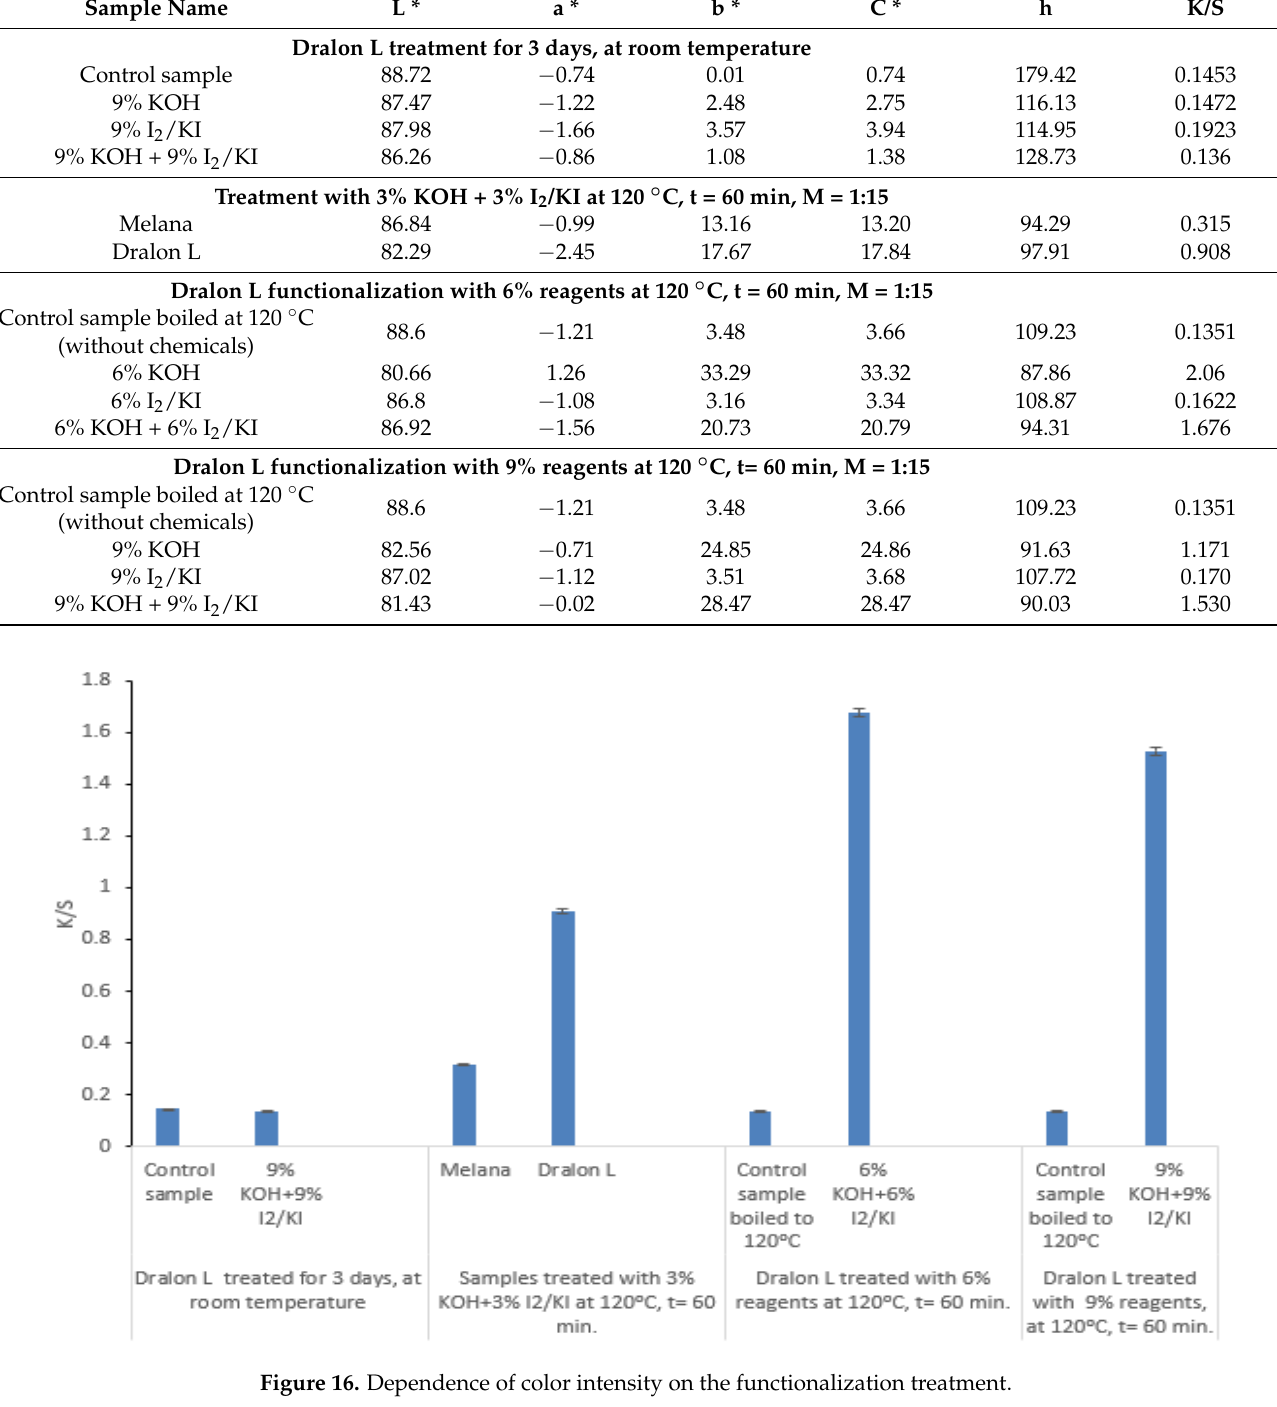
Figure 16. Dependence of color intensity on the functionalization treatment. The generation of new functional groups of iodine-oxime types (I-C=N-OH) by the conversion of a part of fraction of nitrile groups (-C ≡ N) determines the increase of the tinctorial capacity of acrylic fibers and creates the possibility of dyeing with acid dyes, in acid media, which is not typical for PAN fibers. The emergence of the iodine-oxime functional group was confirmed by the starch test [31,32], when the specific blue-black color that indicates the presence of I 3 − in a free state (if doping takes place) did not